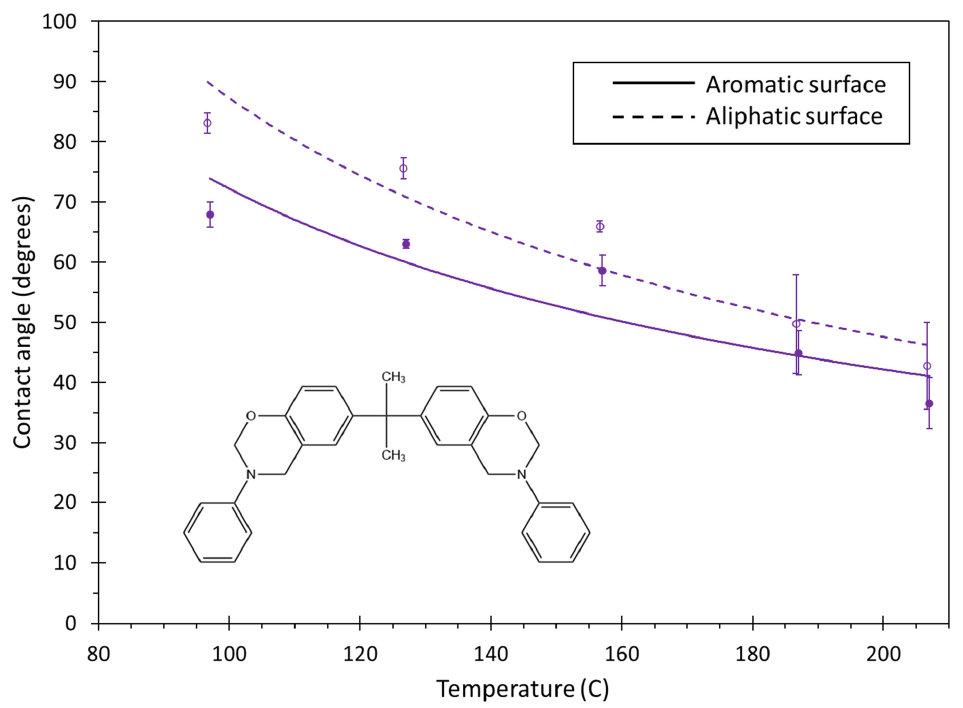
Figure 21. Plot of contact angle vs. temperature for benzoxazine. The lines are curve fits to the data, and the error bars represent the standard error of replicate predictions.